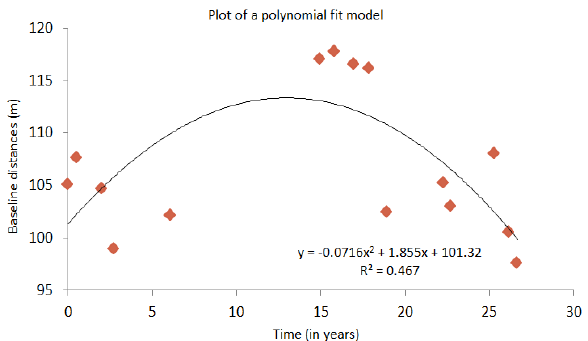
Figure 12. Polynomial regression fit between baseline distances and time for transect number 490 with Landsat midlines for